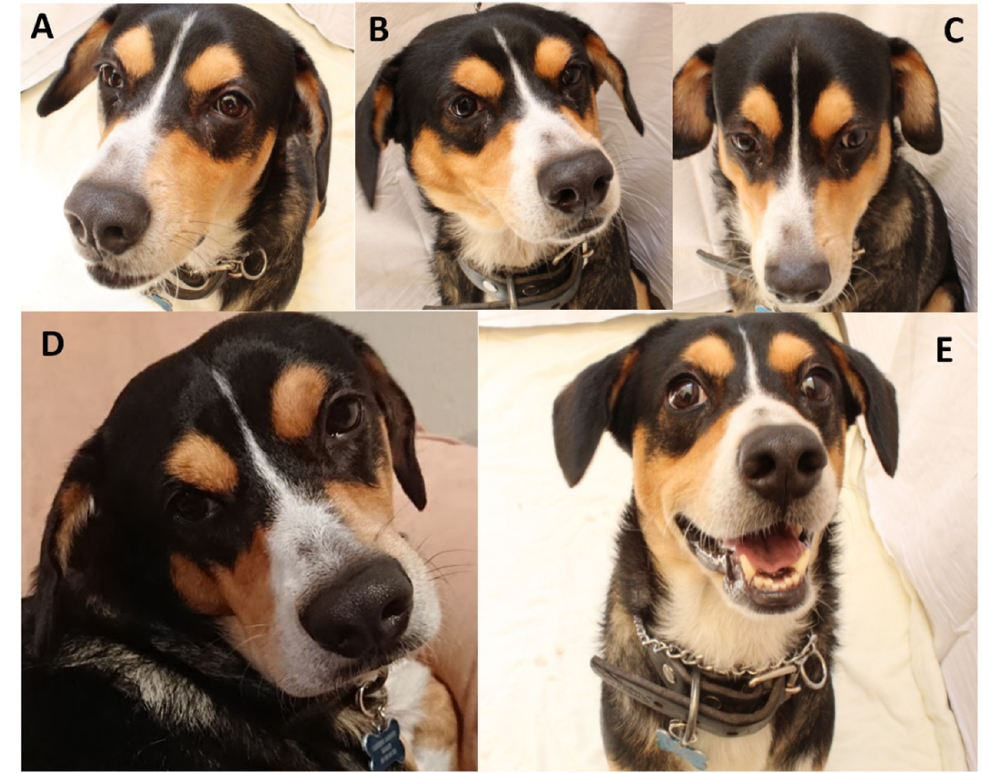
Figure 6. Changes in facial expression during exposure to various stimuli. ( A ). Neutral. No relation or expression; ( B ). Anger. Observations include a fixed gaze with ears at medium height or pulled back with flared nostrils and tensed cheeks; ( C ). Fear. The gaze has deviated with the ears pulled back, exposing the frontal region as a signal of submission; ( D ). Surprise. The eyebrows are inexpressive, perhaps with a slight raising of the medial section to give the appearance of large eyes, with the ears at medium height; ( E ). Pleasure. Eyebrows and ears are clearly raised with the mouth open and tension in the labial commissure.